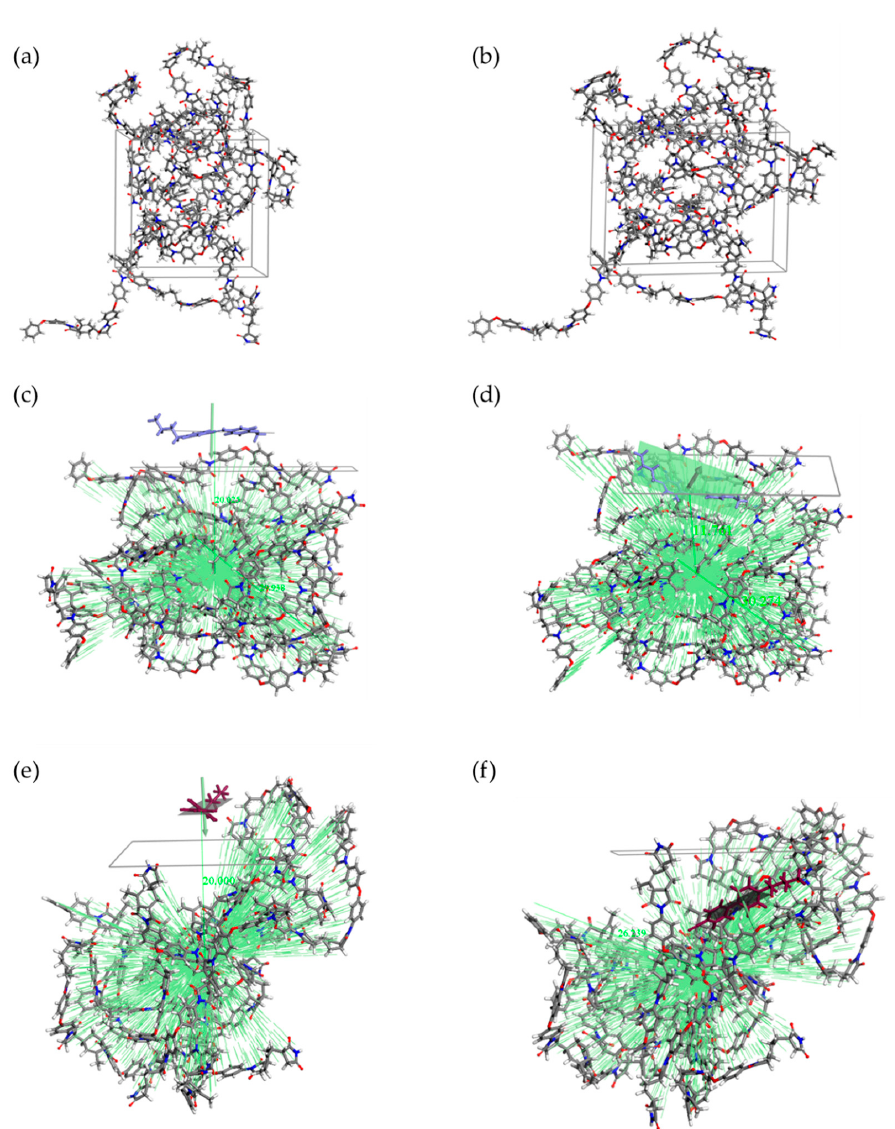
Figure 5. Considering the same procedure and methodology used in Figure 4, here are presented snapshots of the periodic PI-ODA cell before ( a ) and after the stretch process ( b ), and the initial system of the polymer surface and MBBA ( c ), and respectively, 5CB ( e ). From the multiple outputs of the quench procedure, the system with the lowest energy was chosen (( d ) for system with MBBA, ( f ) for the system with 5CB).